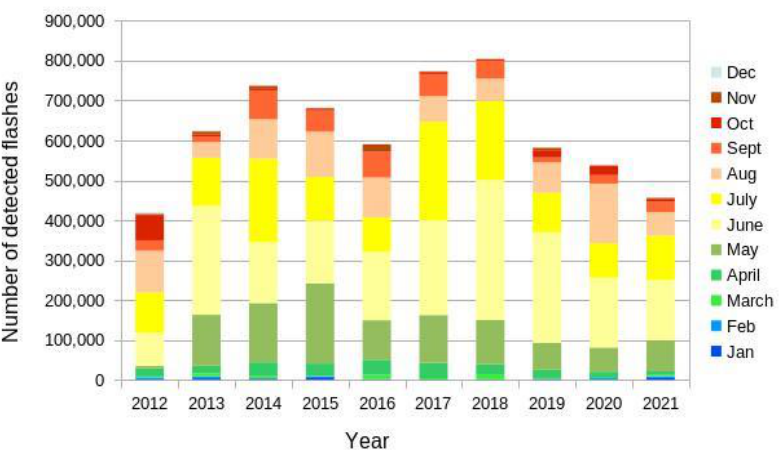
Figure 2. Annual distribution of the flashes detected by ATDnet over the studied domain for the period 2012 – 2021.